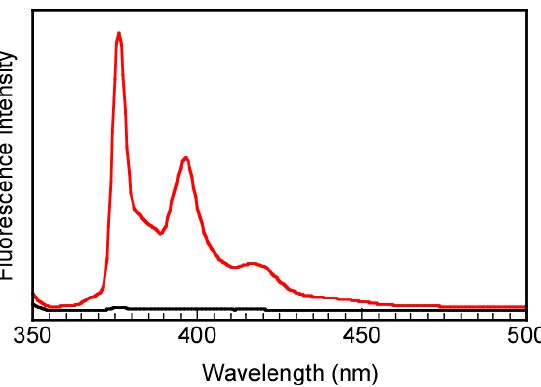
Figure 8. Fluorescence spectra for PEG-Py after dialysis against water at pH 10 for 10 days excited at 334 nm in the presence (—) and absence (—) of the PIC vesicle.